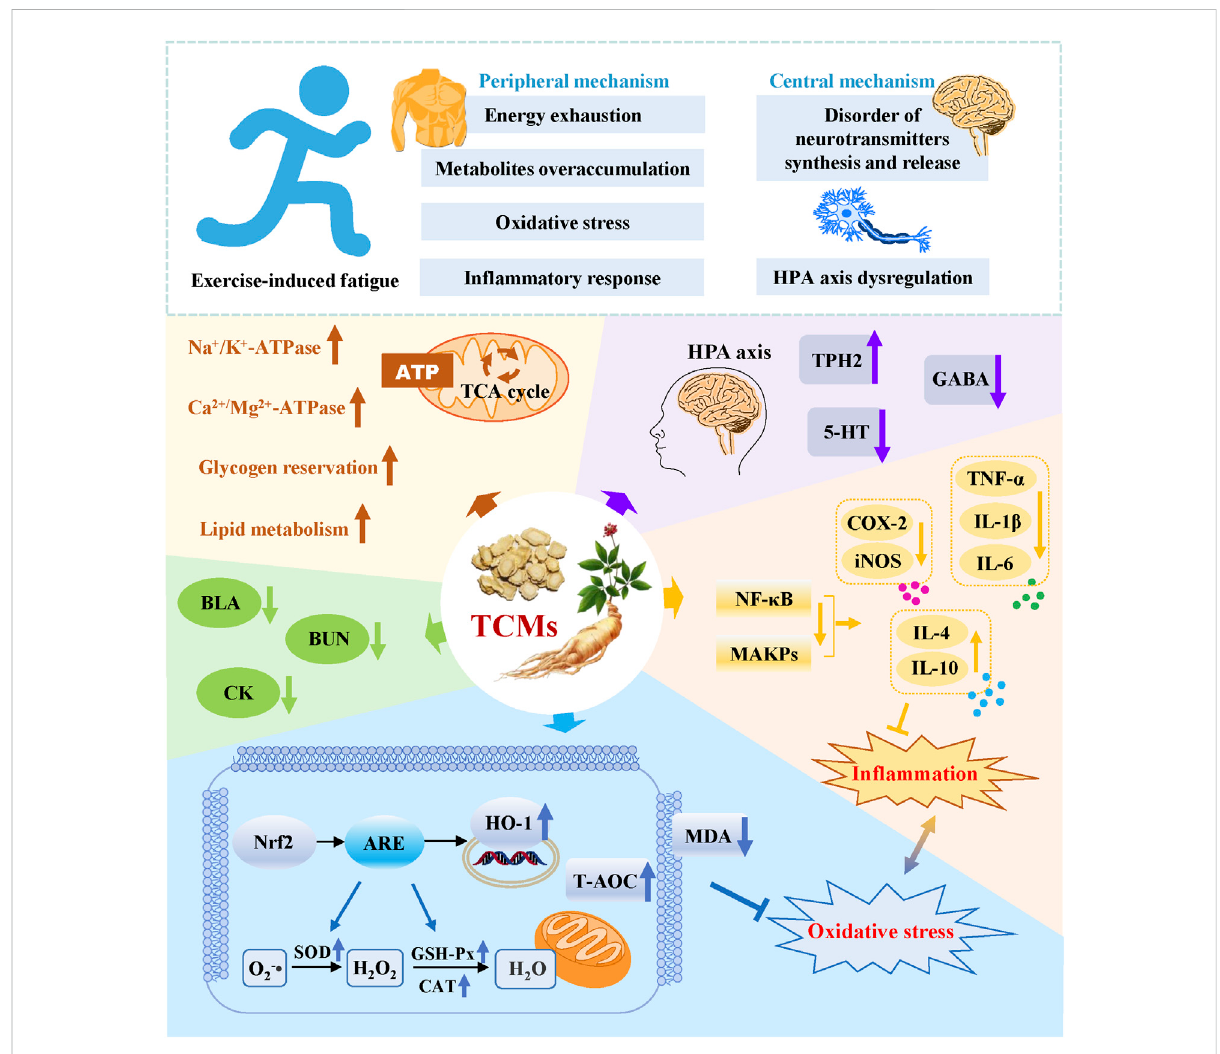
FIGURE 3 Possible molecular mechanisms of TCMs in relieving exercise-induced